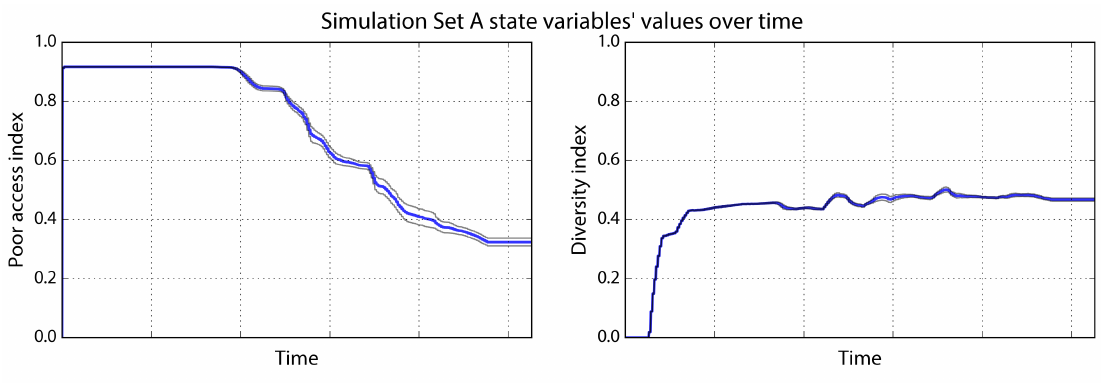
Figure 2. Set A’s state variables from initialization through the end of the simulation, with mean value (blue) and 95% confidence interval (gray) across 50